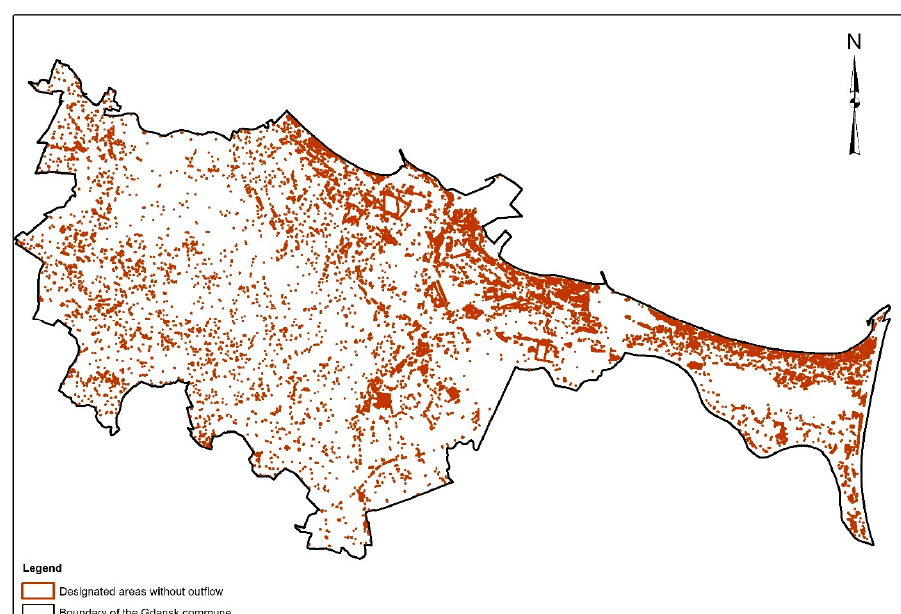
Figure 7. Designated areas without outflow